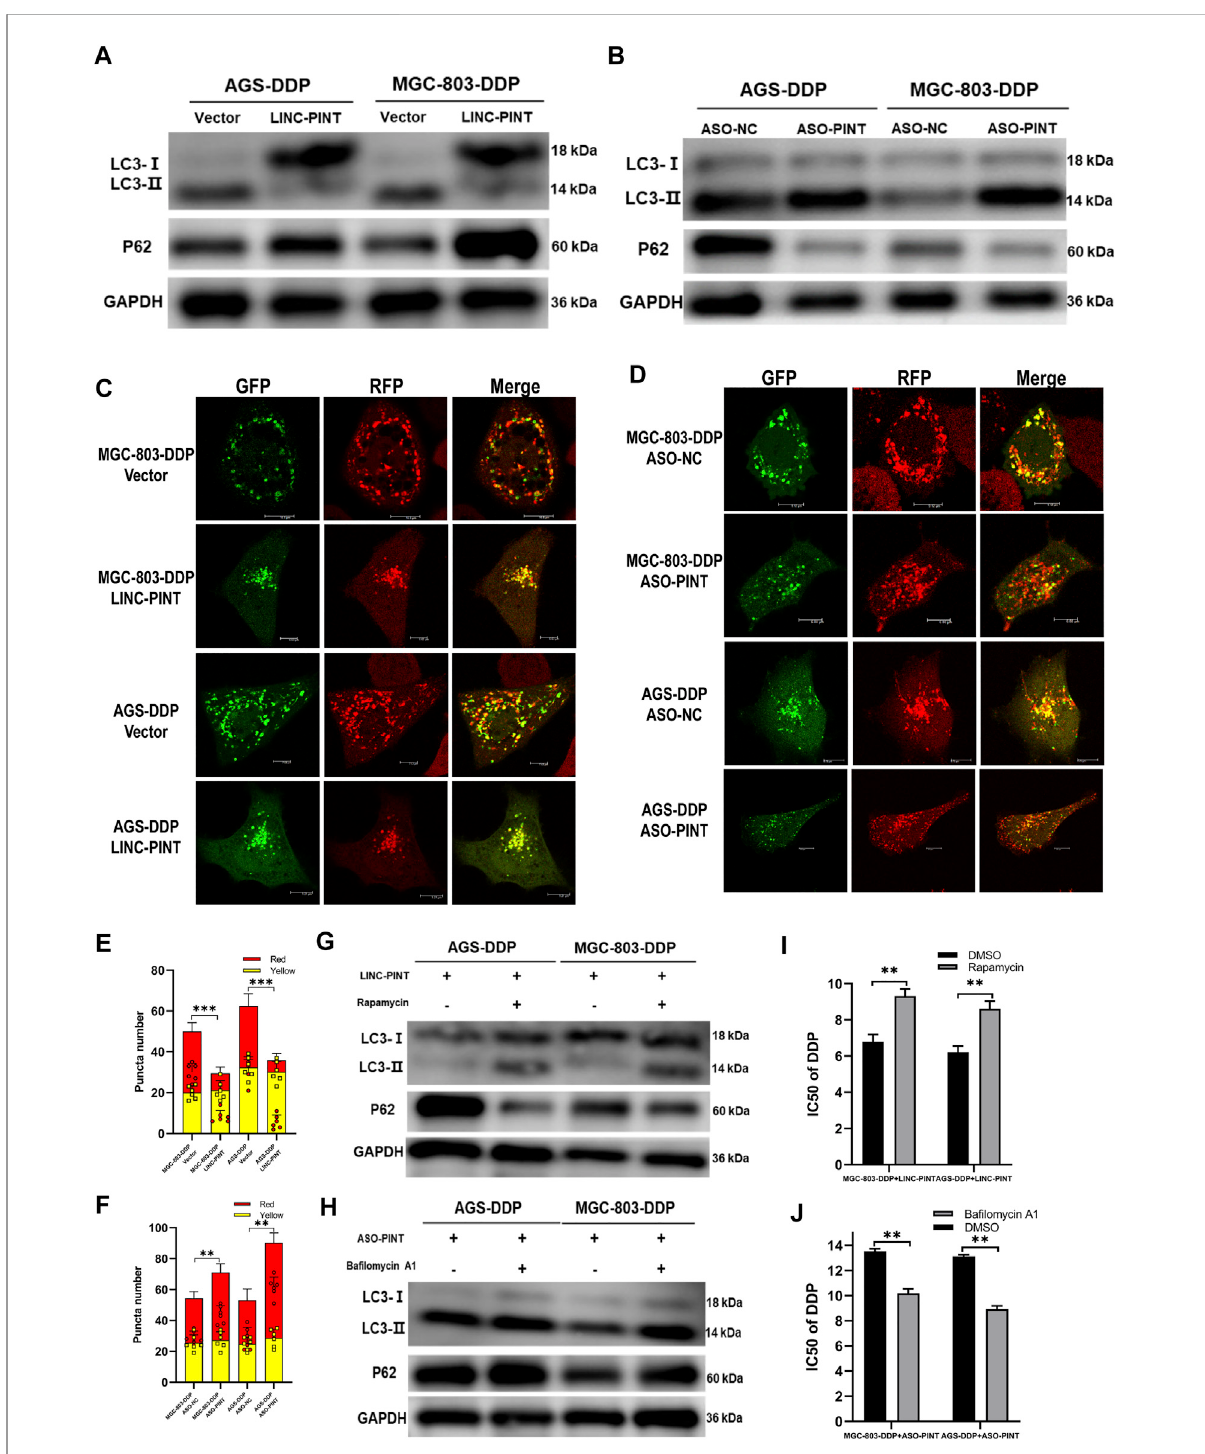
FIGURE 4 LINC-PINT inhibited DDP-resistance via attenuated autophagy. (A) Western blotting for LC3 and p62 in LINC-PINT overexpressed AGS-DDP andMGC-803-DDP cells. (B) Westernblotting for LC3and p62in LINC-PINT silenced AGS-DDP and MGC-803-DDPcells. (C) Confocal microscopy to observe autophagy fl ux in LINC-PINT overexpressed MGC-803-DDP and AGS-DDP cells. (D) Confocal microscopy to observe autophagy fl ux in LINC-PINT silenced MGC-803-DDP and AGS-DDP cells. (E) Statistics of red and yellow puncta number in LINC-PINT overexpressed MGC- 803-DDP and AGS-DDP cells [cell image: (C) ]. (F) Statistics of red and yellow puncta number in LINC-PINT silenced AGS-DDP and MGC-803-DDP cells[cellimage: (D) ]. (G)